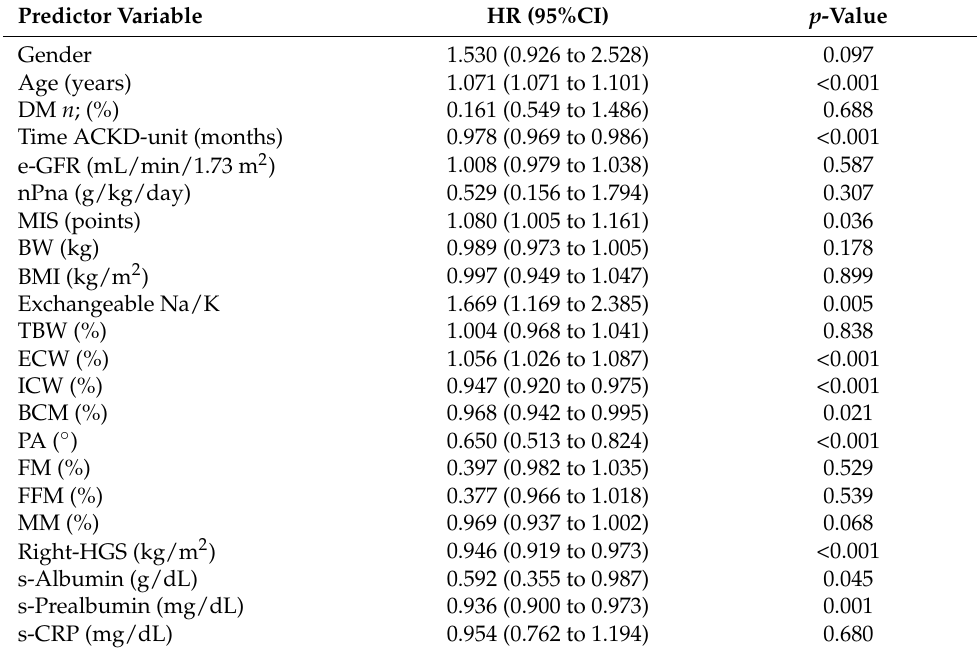
Table 3. Univariate Cox proportional hazards analysis of all-cause mortality risk in stage 3b, 4–5 chronic kidney disease patients.